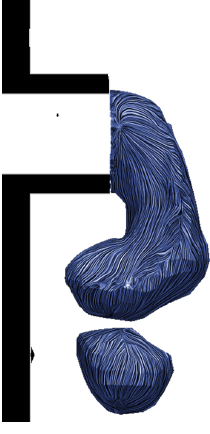
Figure 5. Plunging